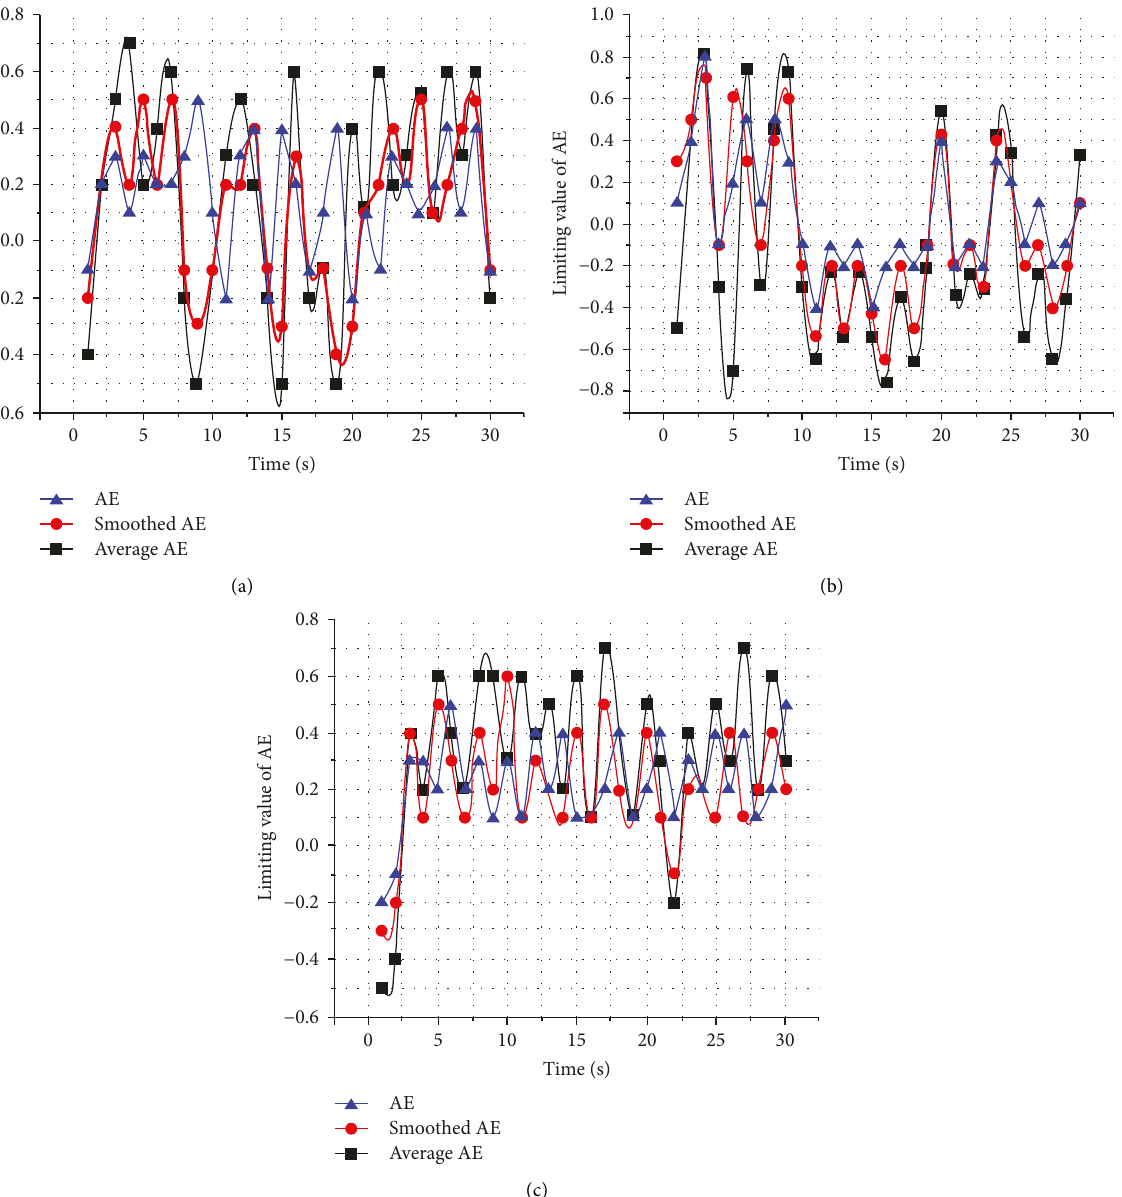
Figure 5: (a) No performing cues analysis. (b) Single performing cues analysis. (c) Multiple performing cue analysis for the proposed MESDT (with the classical opera